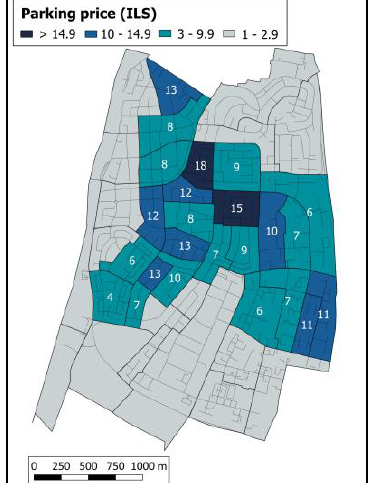
Figure 10. Parking search times in Bat Yam with city quarter pricing: Average parking search times (left); average difference in search times compared to non-priced parking (middle); and probability to cruise longer than 2.5 minutes (right).